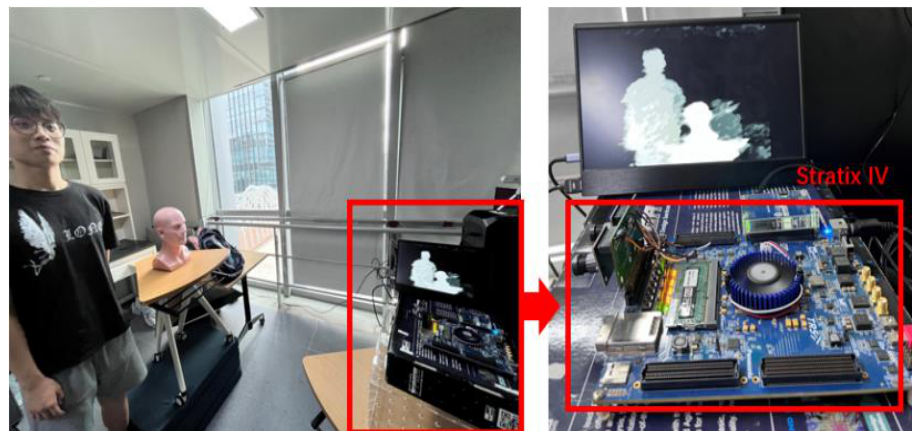
Figure 17. FPGA demonstration.